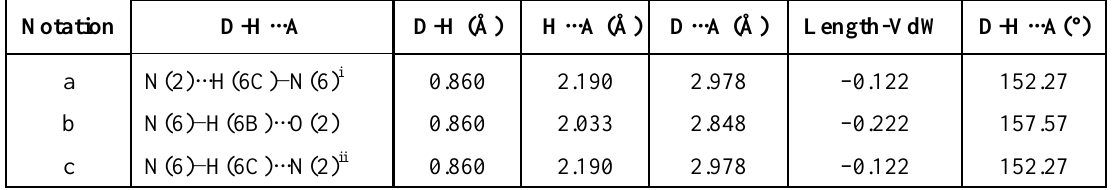
Table 1. Hydrogen bond geometry in compound